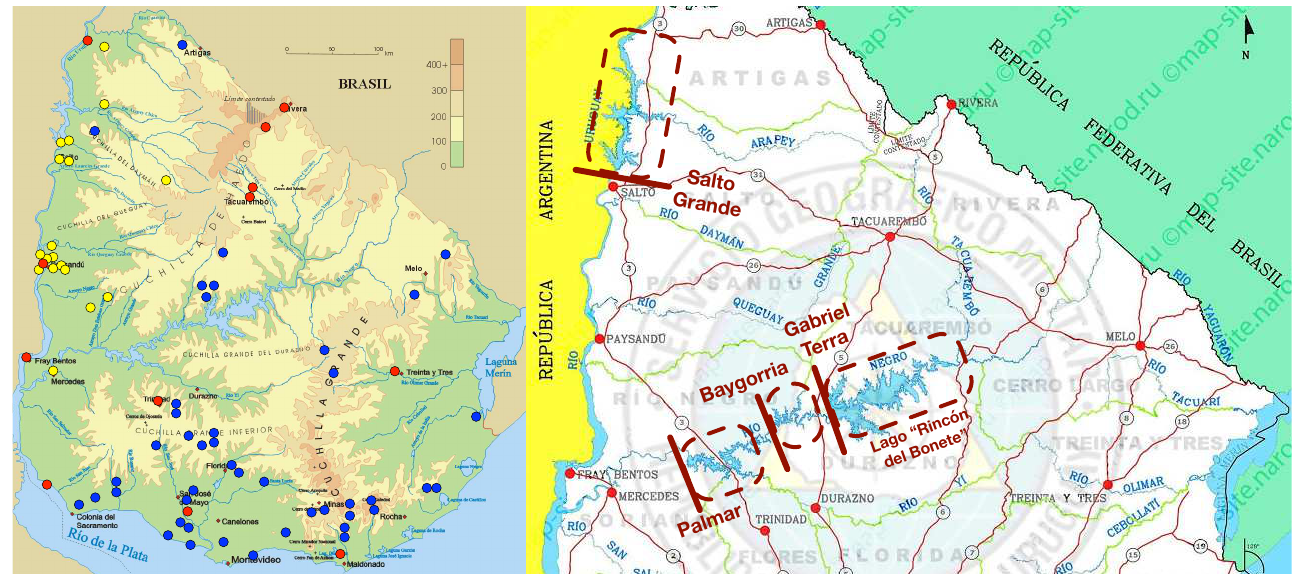
Figure 1. Geographical distribution of renewable sources. Leftmost: wind-power (blue), solar-photovoltaic (yellow) and biomass thermal units (red). Rightmost: hydroelectric dams. [source UTE: 2019 and